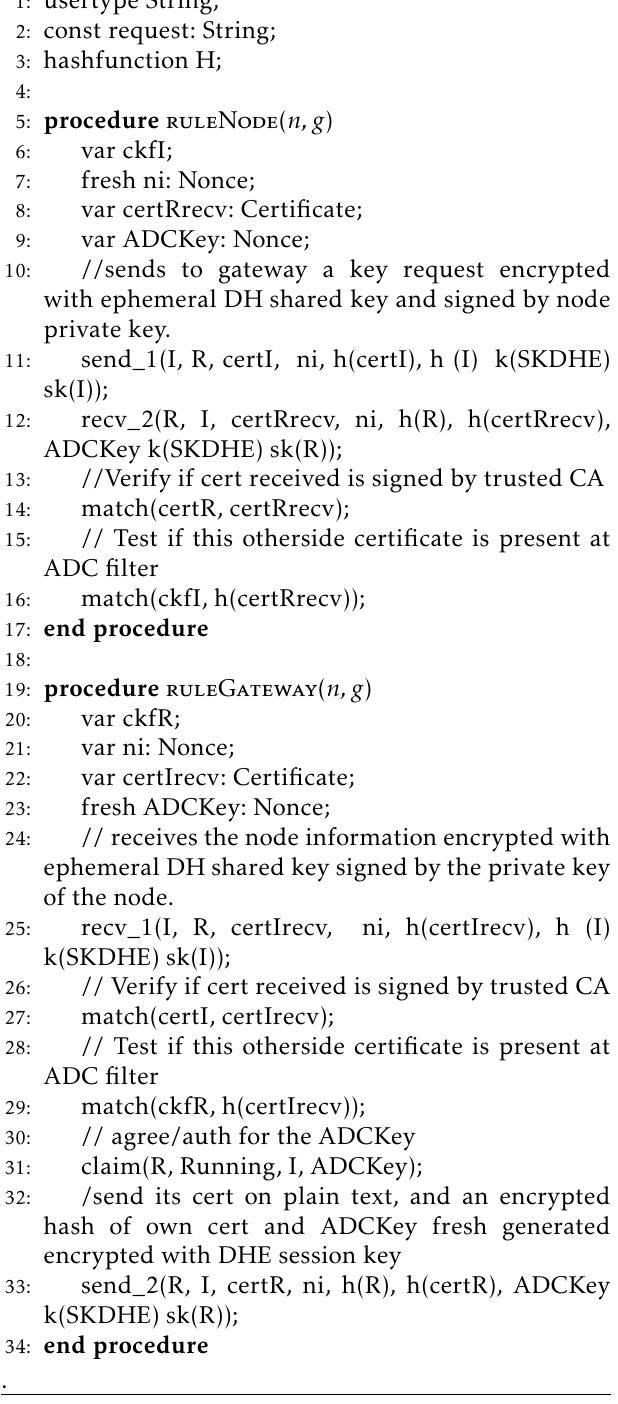
Algorithm 3 Key transport algorithm rules: Gateway (g) and Node (n). BNF Syntax used by Scyther software